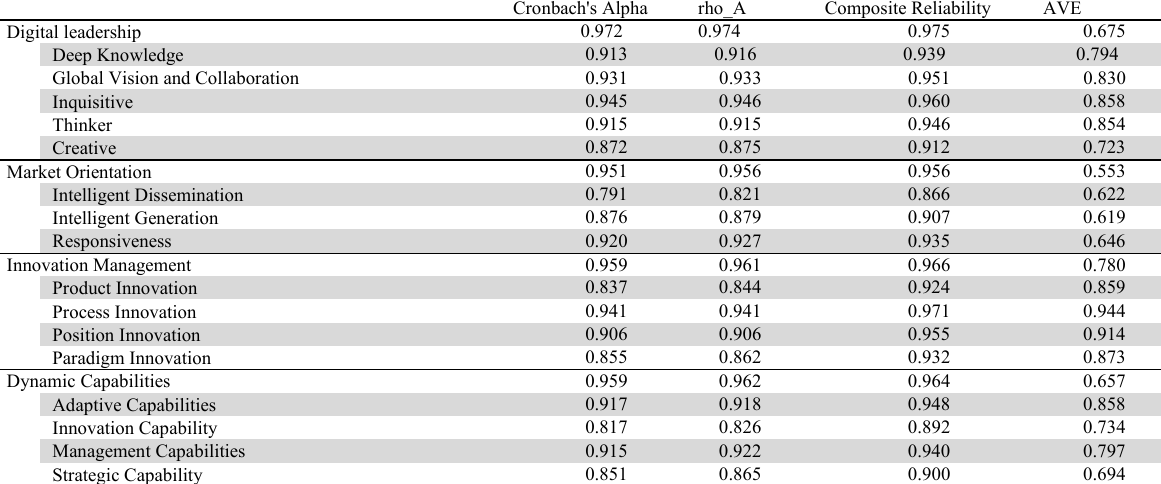
Construct’s Reliability Test